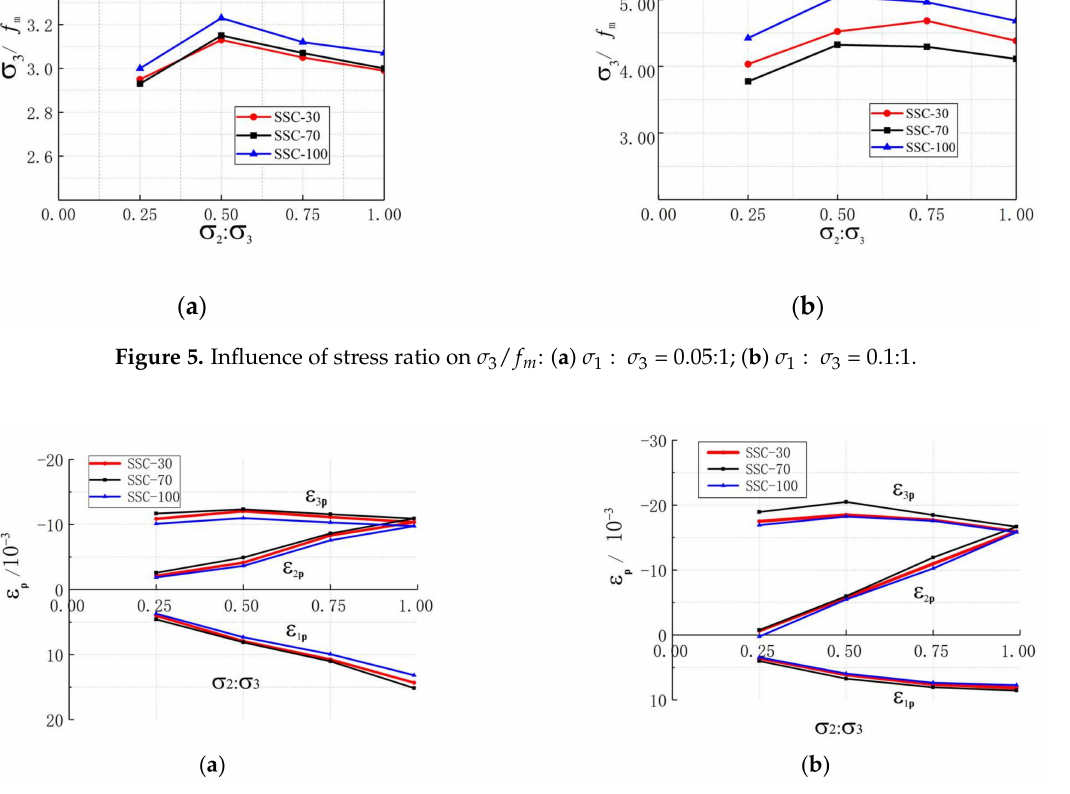
Figure 6. Variation of peak strain with stress ratio under triaxial compression: ( a ) σ 1 : σ 3 = 0.05:1; ( b ) σ 1 : σ 3 =